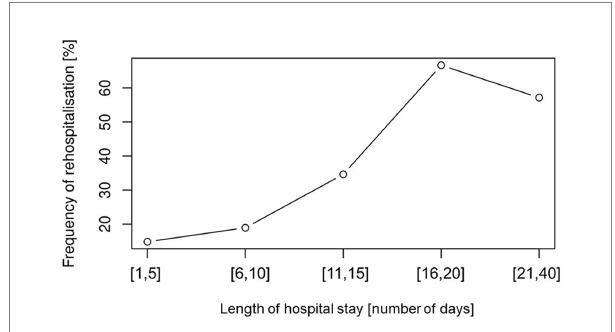
FIGURE 1 Frequency of rehospitalization versus length of hospital stay (LOHS). Rehospitalization rates increases with longer length of hospital stay in approximately lineal